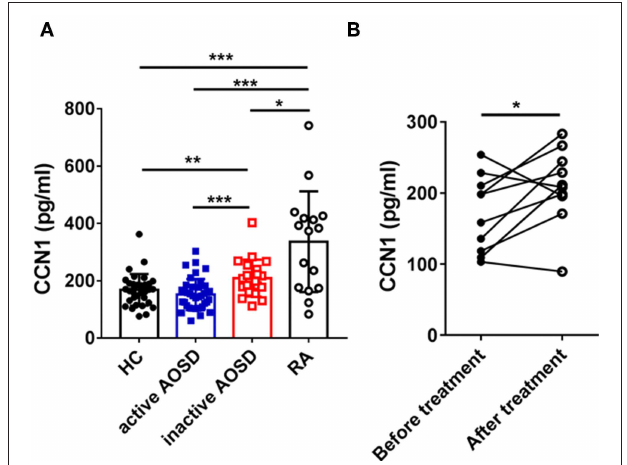
FIGURE 1 | The serum levels of cysteine-rich angiogenic inducer 61 (Cyr61) in adult-onset Still’s disease (AOSD) patients are shown. (A) The serum levels of Cyr61 in healthy control subjects (HC) (•, n = 34) and active AOSD ( (cid:4) , n = 39), inactive AOSD ( (cid:3) , n = 21), and rheumatoid arthritis (RA) ( ◦ , n = 16) patients are shown. The non-parametric Mann–Whitney U -test was used to compare differences between each group, and data represent median with interquartile range (IQR). (B) The serum levels of Cyr61 in patients before (•) and after ( ◦ ) clinical treatment ( n = 11) were analyzed by paired t -test. * P < 0.05, ** P < 0.01, *** P < 0.001.